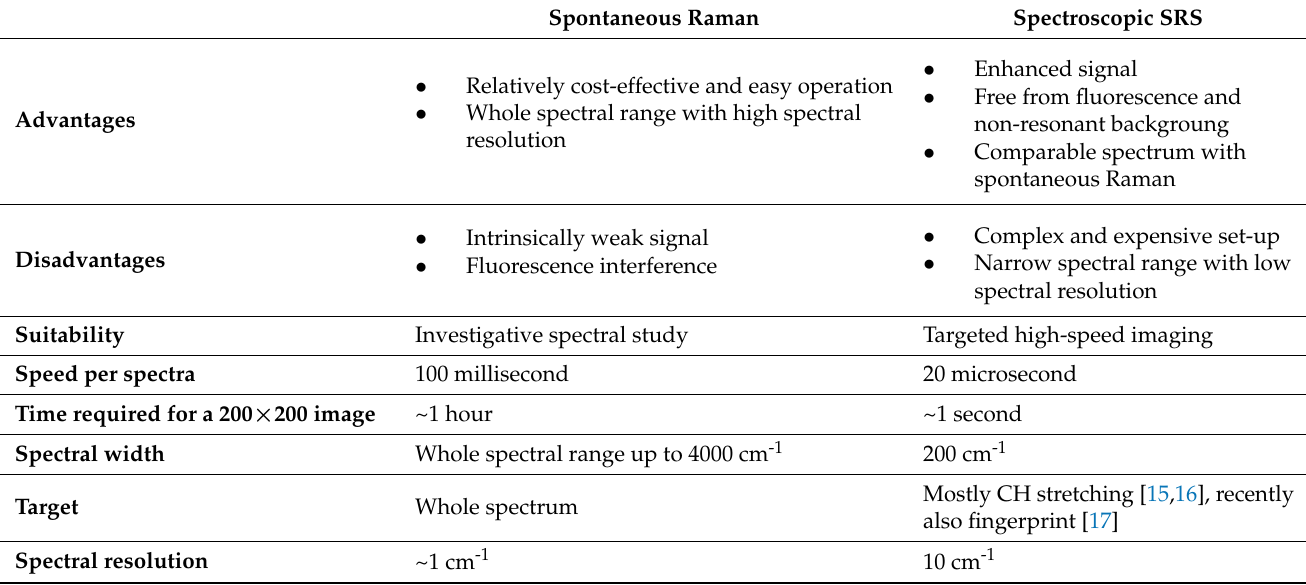
Table 1. Comparison of spontaneous Raman spectroscopy and spectroscopic SRS microscopy, which are complementary to each other and can be used